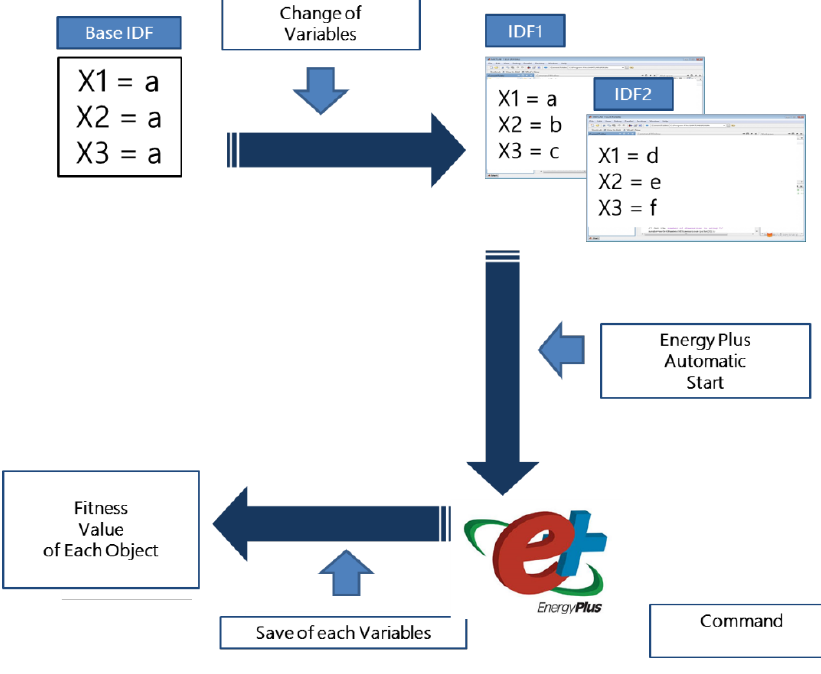
Figure 6. Content of Command in M-Script.